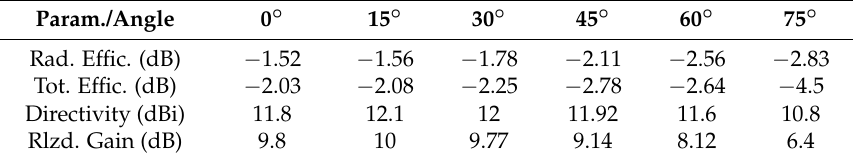
Figure 17. 3D radiation beams of the 5G smartphone antenna in the vicinity of the user’s hands at ( a ) 0°, ( b ) 15°, ( c ) 30°, ( d ) 45°, ( e ) 60°, and ( d ) 75°. Table 3. The properties of the 5G antenna with the user’s hands at different scanning angles.